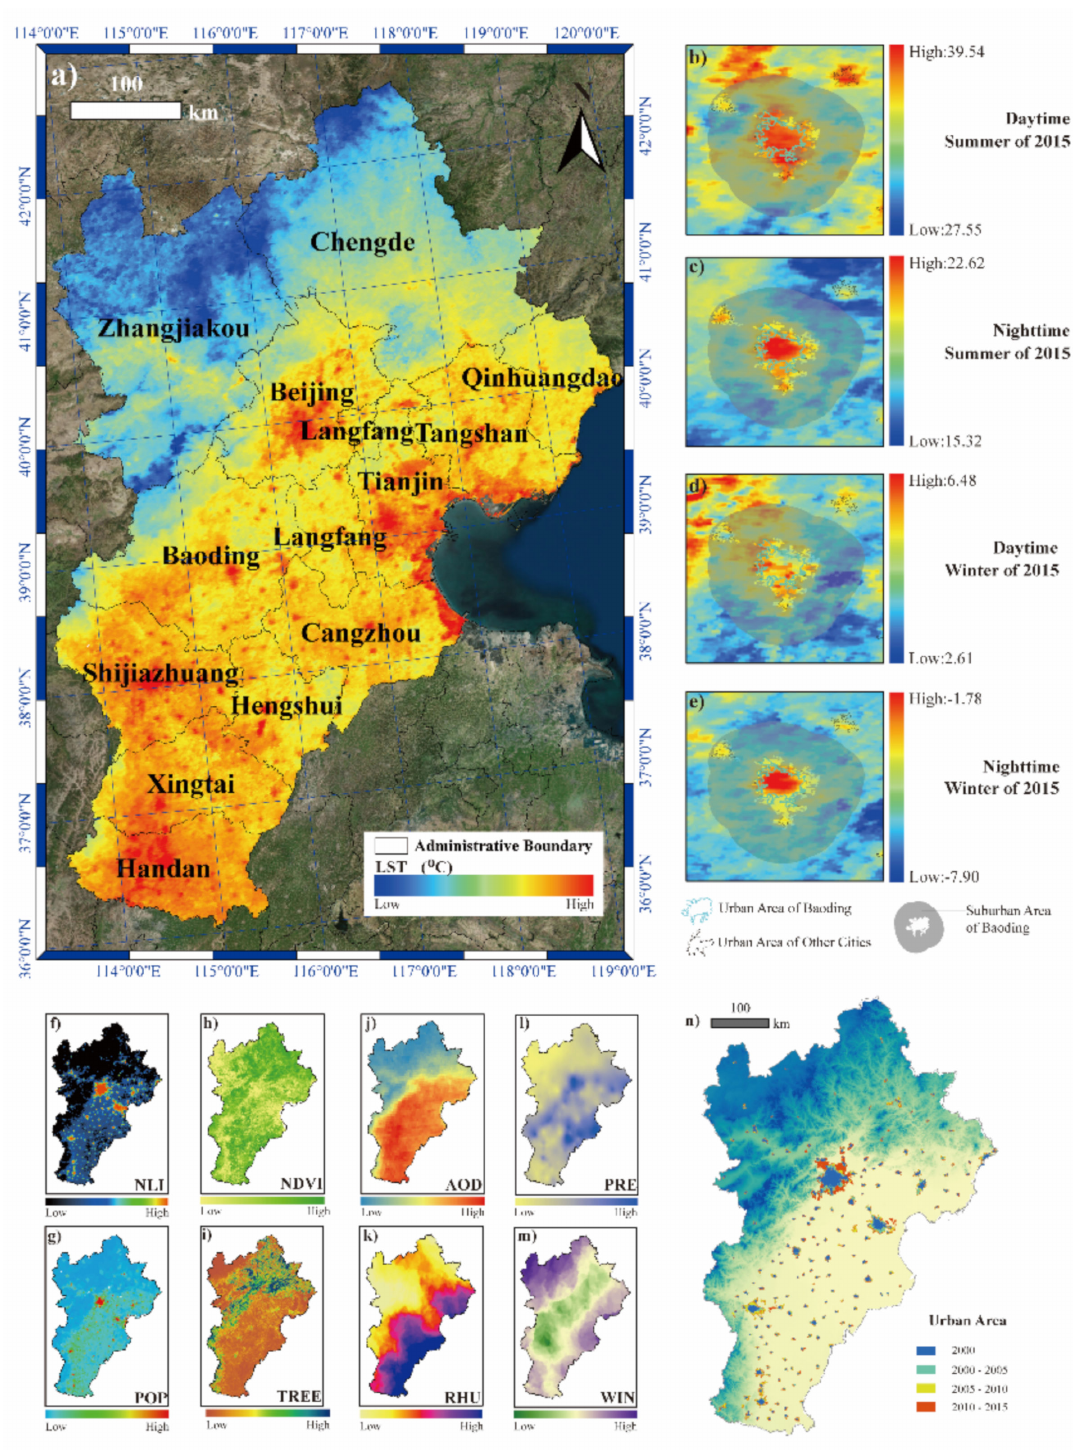
Figure 2. Land surface temperature of the 2015 winter nights ( a ), urban-rural areas maps for SUHII calculation ( b – e ); ( f – m ) shows other raster layers taken into consideration and urban areas from 2000 to 2015 ( n